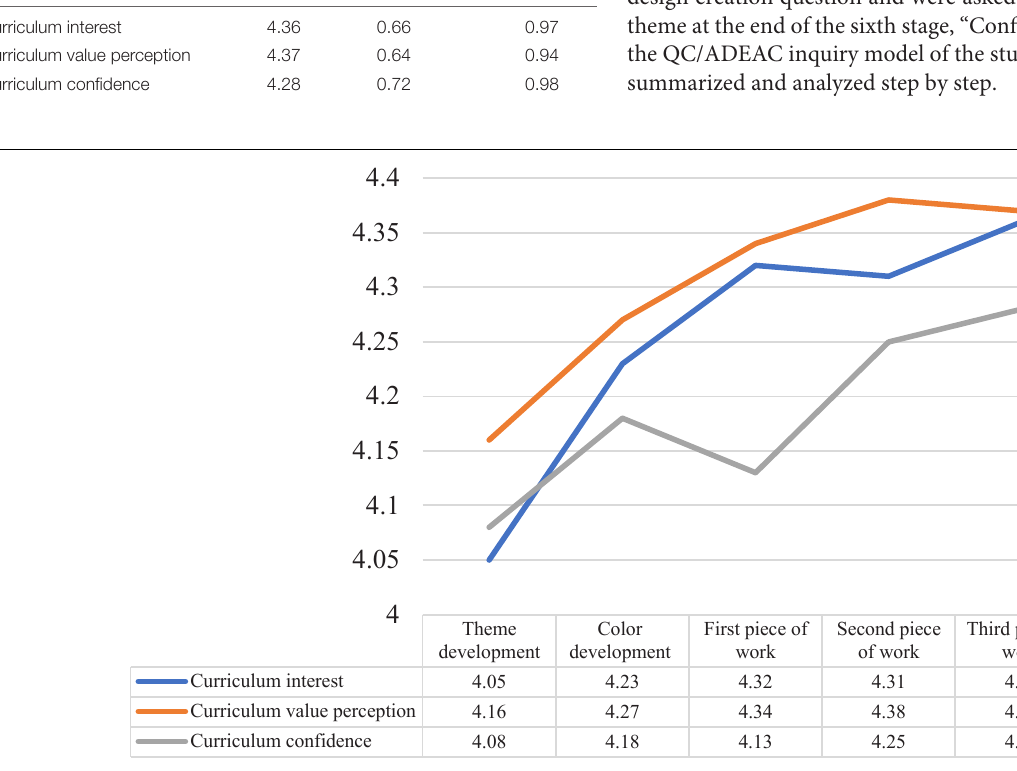
FIGURE 3 | Time series